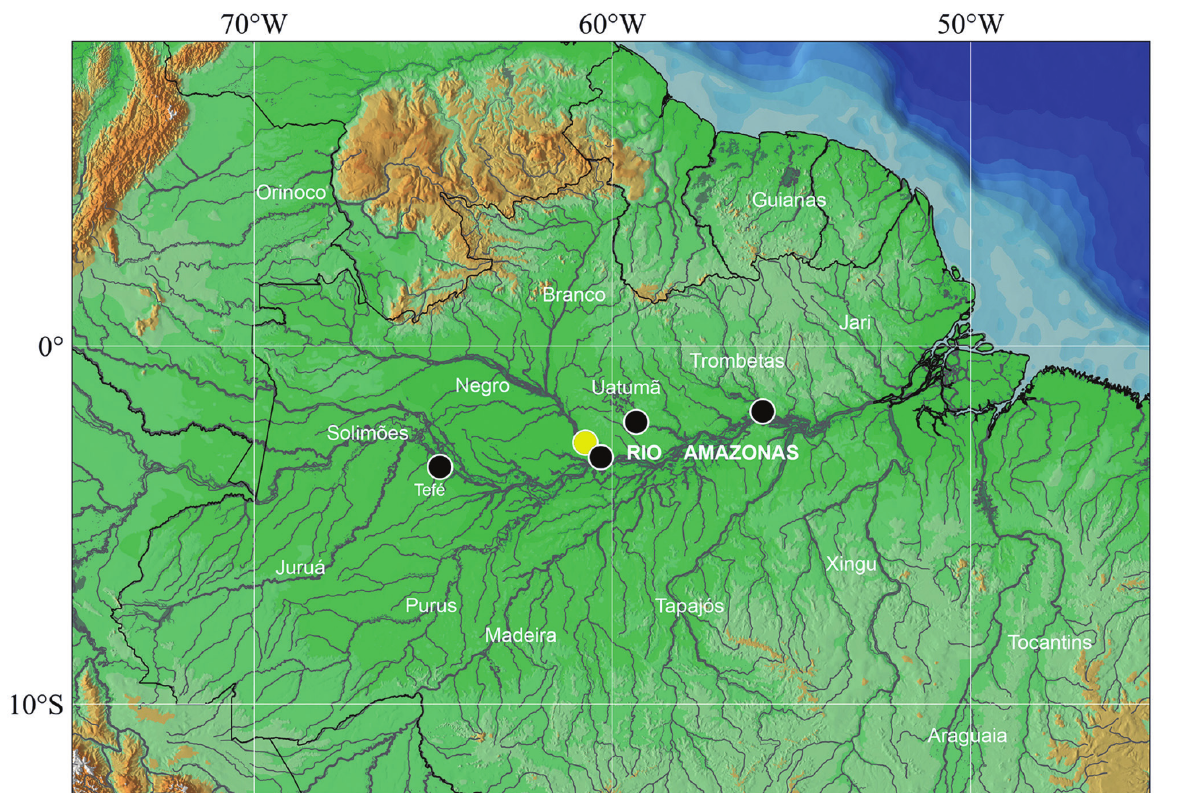
Fig. 4. Map of northern South America showing the distribution of Tetragonopterus manaos ; yellow circle represents the holotype and black circles represent